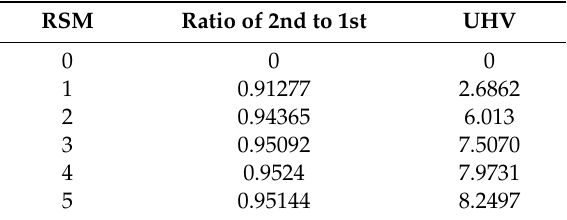
Table 3. Equivalent relationship of DC bias current of RSM to